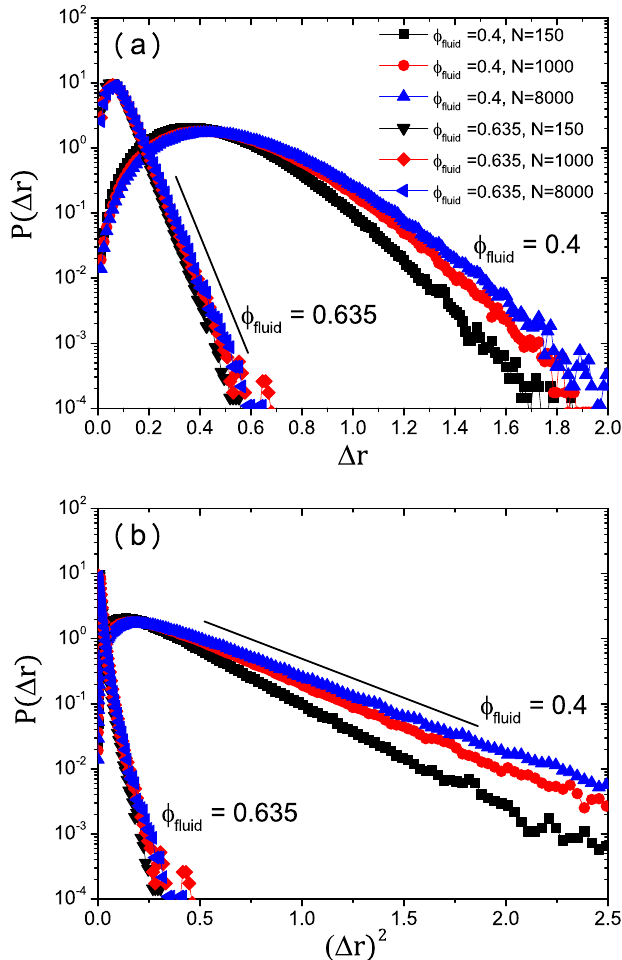
Figure 11: (a): Probability distribution function P ( ∆ r ) of particle displacements during a − r fluid | . The straight line corresponds to P ( ∆ r ) ∝ exp [ − a ∆ r ] , compression, ∆ r = | r jam i i where a is a constant. (b): The same distributions P ( ∆ r ) as a function of the quantity ( ∆ r ) 2 . The straight line corresponds to P ( ∆ r ) ∝ exp [ − b ( ∆ r ) 2 ] , where b is a